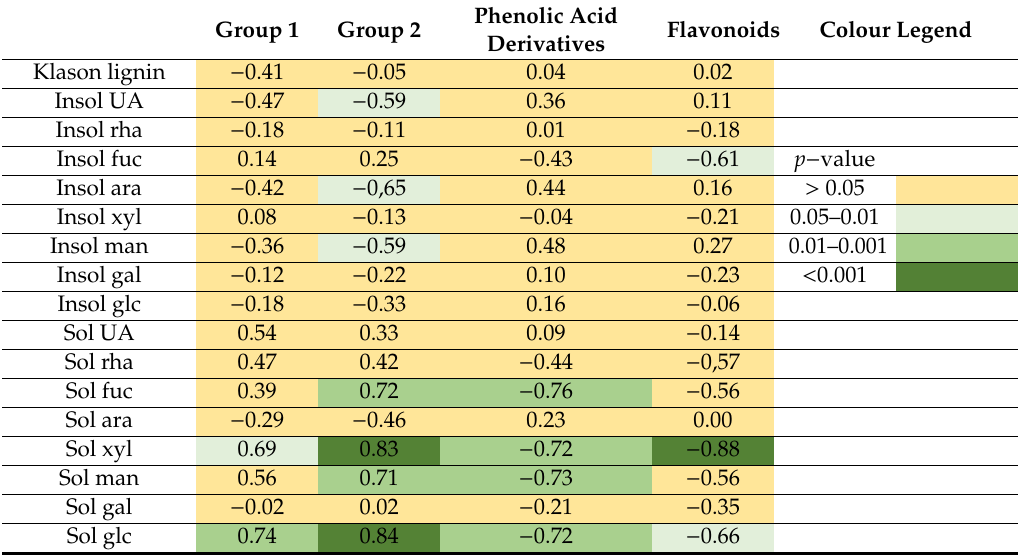
Table 4. Pearson correlation coefficients among dietary fiber constituents and groups of phenolic compounds.